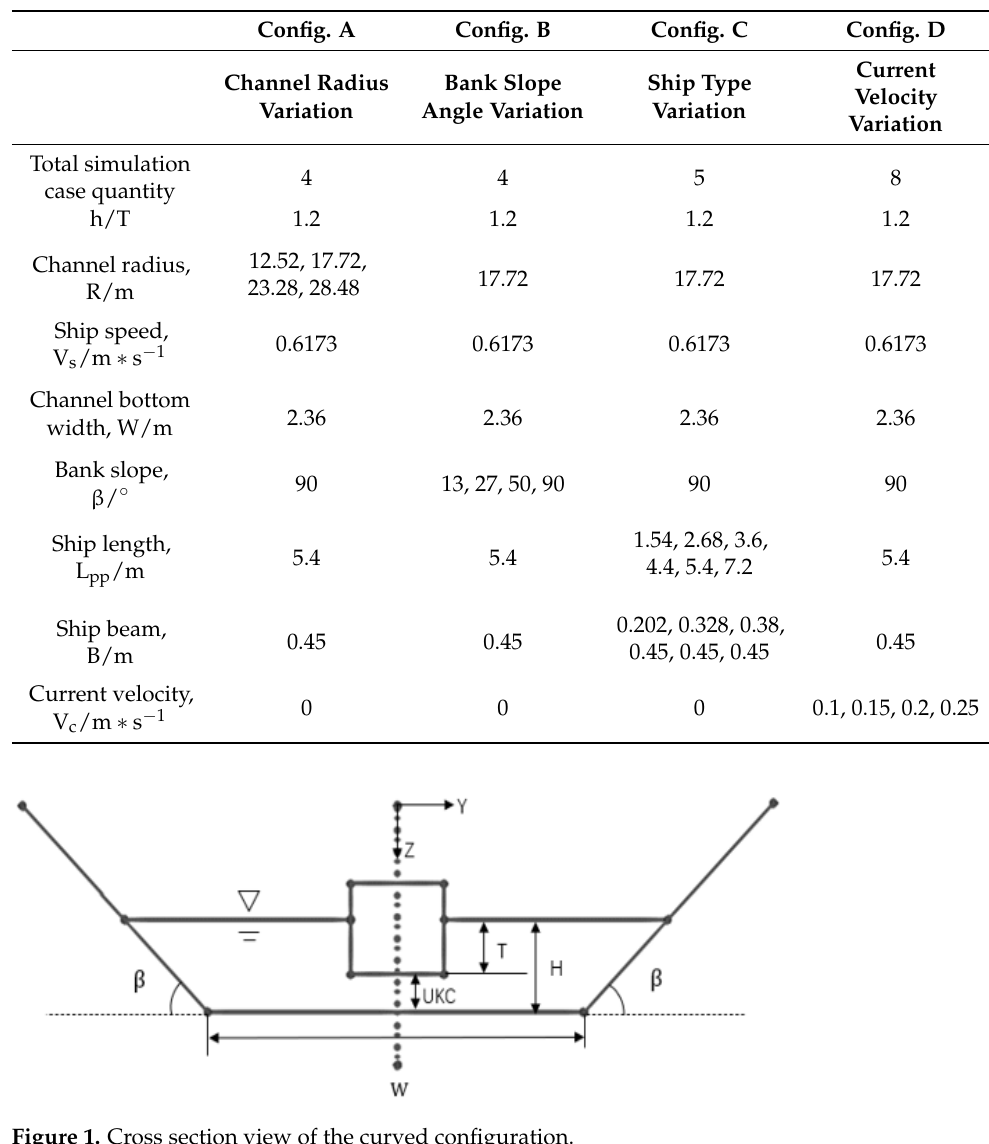
Table 2. Simulation cases in curved configurations.